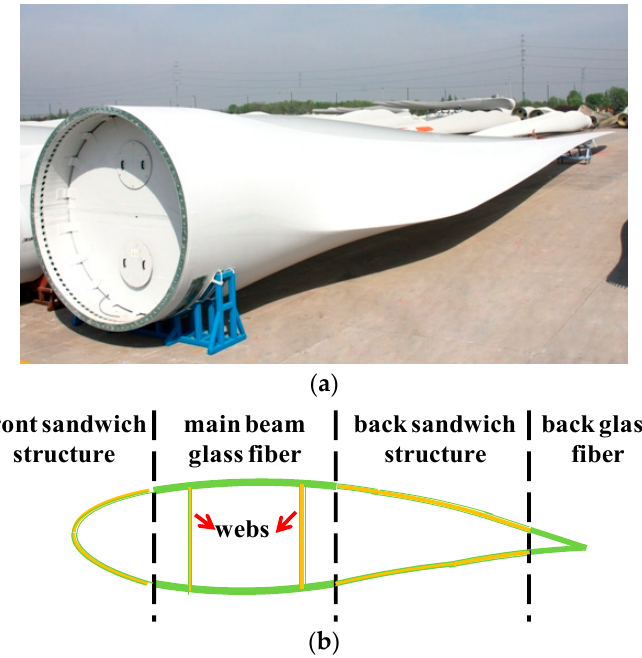
Figure 1. Blade structure: ( a ) real blade; ( b ) cross-section of blade.